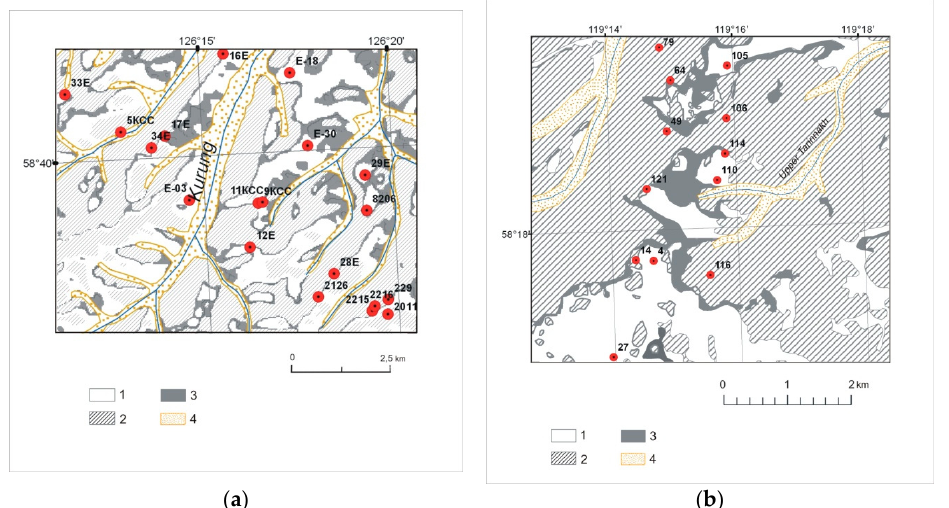
Figure 7. ( a ) Permafrost map of the Elkon Massif, fragment. ( b ) Permafrost map of the Olekma-Chara Upland (Tarinnakh field), fragment. Numbered dots—numbers of geothermal boreholes. 1—unfrozen ground; 2—permafrost; 3—ground with the temperature near 0 °C; 4—river valley.